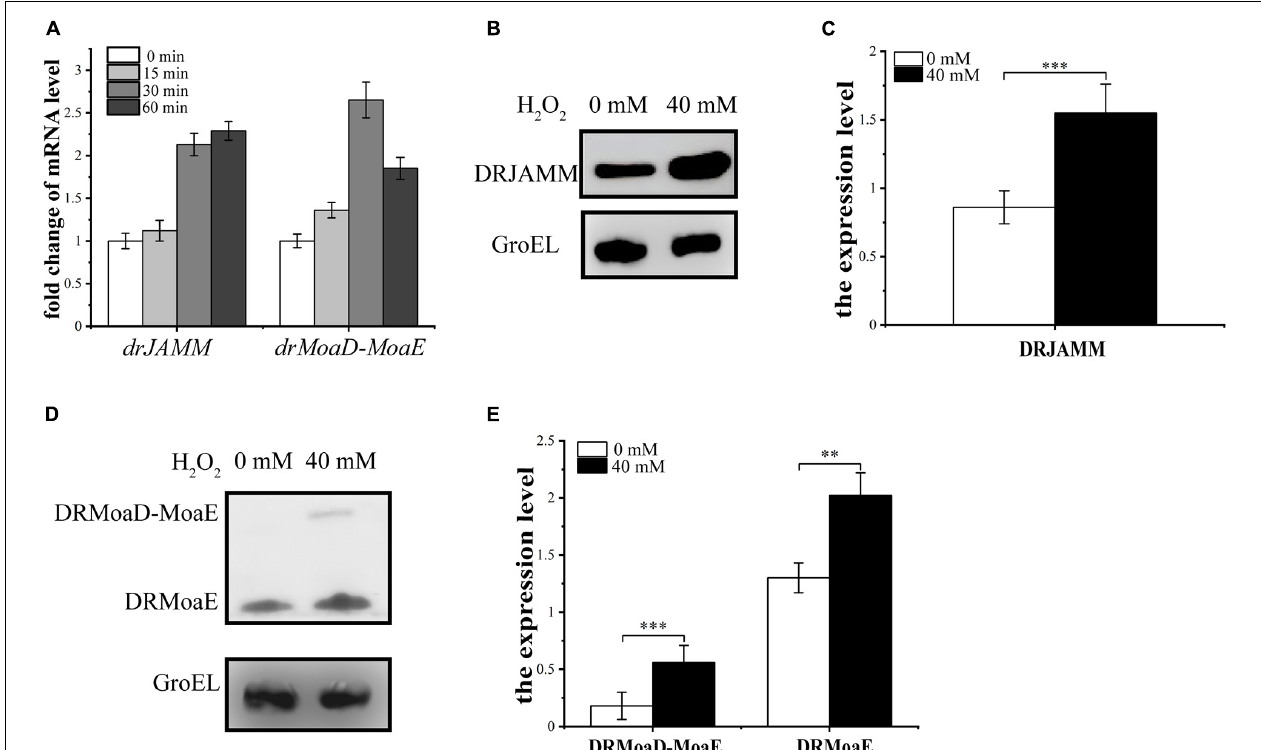
FIGURE 3 | Analysis of transcriptional and expressional levels of drJAMM and drMoaD-MoaE under oxidative stress. (A) The mRNA levels of drJAMM and drMoaD-MoaE after exposure to 40 mM H 2 O 2 for 15, 30, and 60 min. (B,C) The expression level of DRJAMM in the presence or absence of H 2 O 2 . GroEL was used as a control, and an anti-GroEL antibody was used for detection. The relative band strength was scanned and quantified from three independent experiment using ImageJ software. The expression level of each protein was normalized based on the expression level of GroEL, ∗∗ p < 0.01, ∗∗∗ p < 0.001. (D,E) The expression level of DRMoaD-MoaE and DRMoaE in the presence or absence of H 2 O 2 . GroEL was used as a control, and an anti-GroEL antibody was used for detection. The expression level of each protein was normalized based on the expression level of GroEL. Values were means of three independent assays (mean ± SD), ∗∗ p < 0.01, ∗∗∗ p < 0.001.